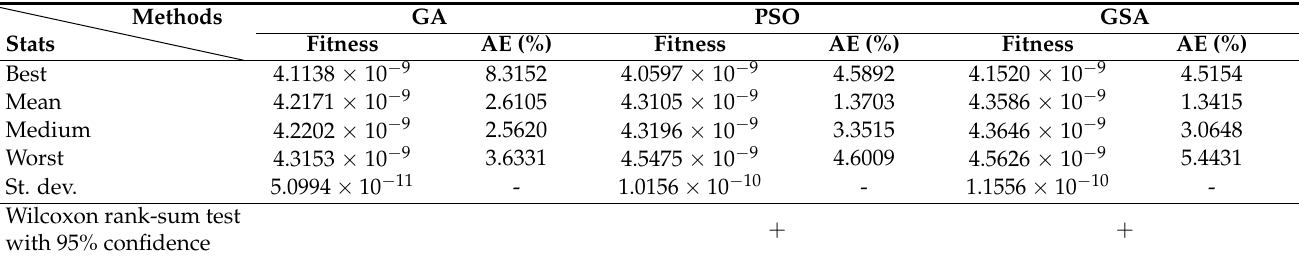
Table 8. Parameters obtained with the optimization methods for the single-phase transformer 33 MVA, √ 230,000/ 3–34,500 V at 60 Hz.